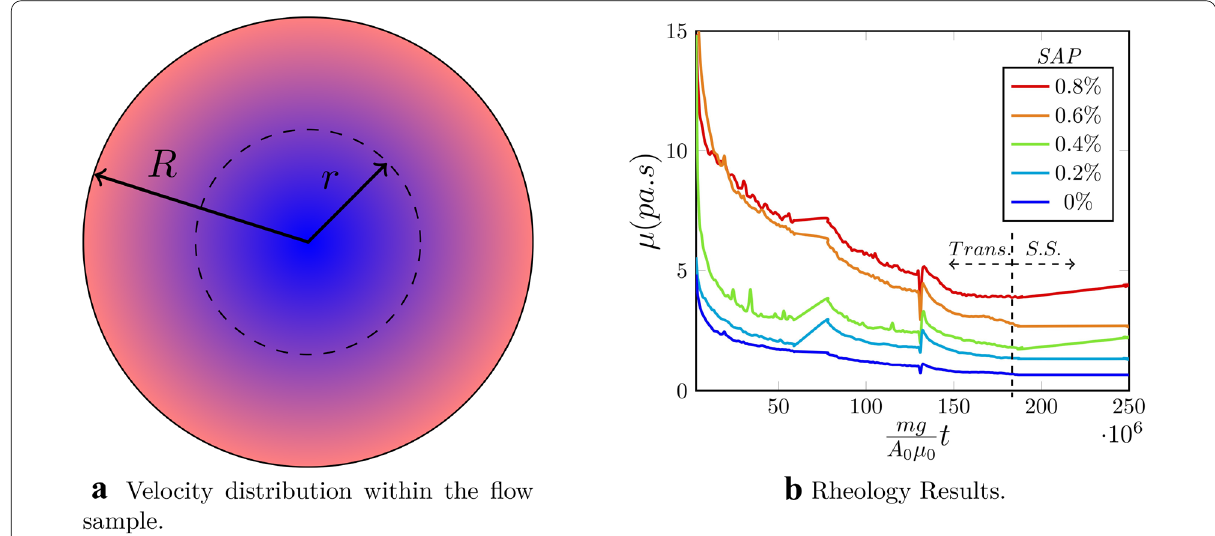
Fig. 4 Further analysis of the mortar